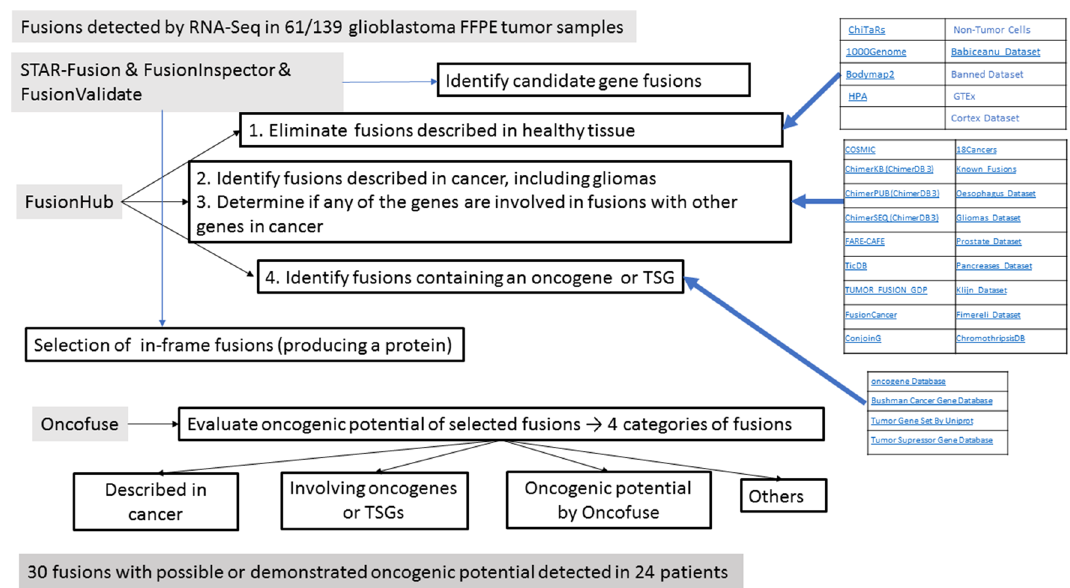
Figure 2. Procedures and data bases used in the present study to select the fusions with oncogenic potential. From the long list of fusions detected by RNA-Seq, we used STAR-Fusion to detect fusion genes and FusionInspector to validate predicted fusions. We then used FusionHub to eliminate fusions previously described in healthy tissue, identify fusions previously described in cancers, and explore whether either gene had been identified as an oncogene or tumor suppressor gene (TSG) or had been associated with cancer. We next used FusionValidate to select only in-frame fusions and finally ran Oncofuse to predict the oncogenic potential of each